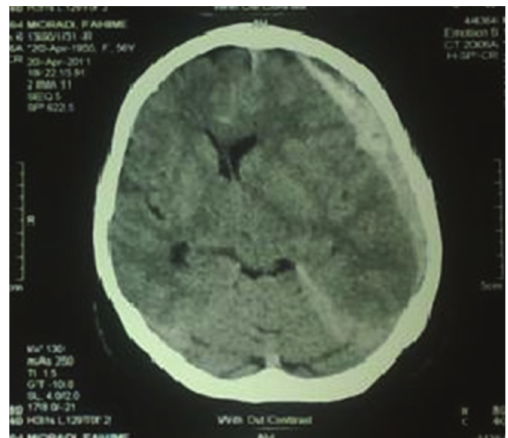
Figure 2: Brain CT scan showed acute SDH of the left frontotem- poral region and midline